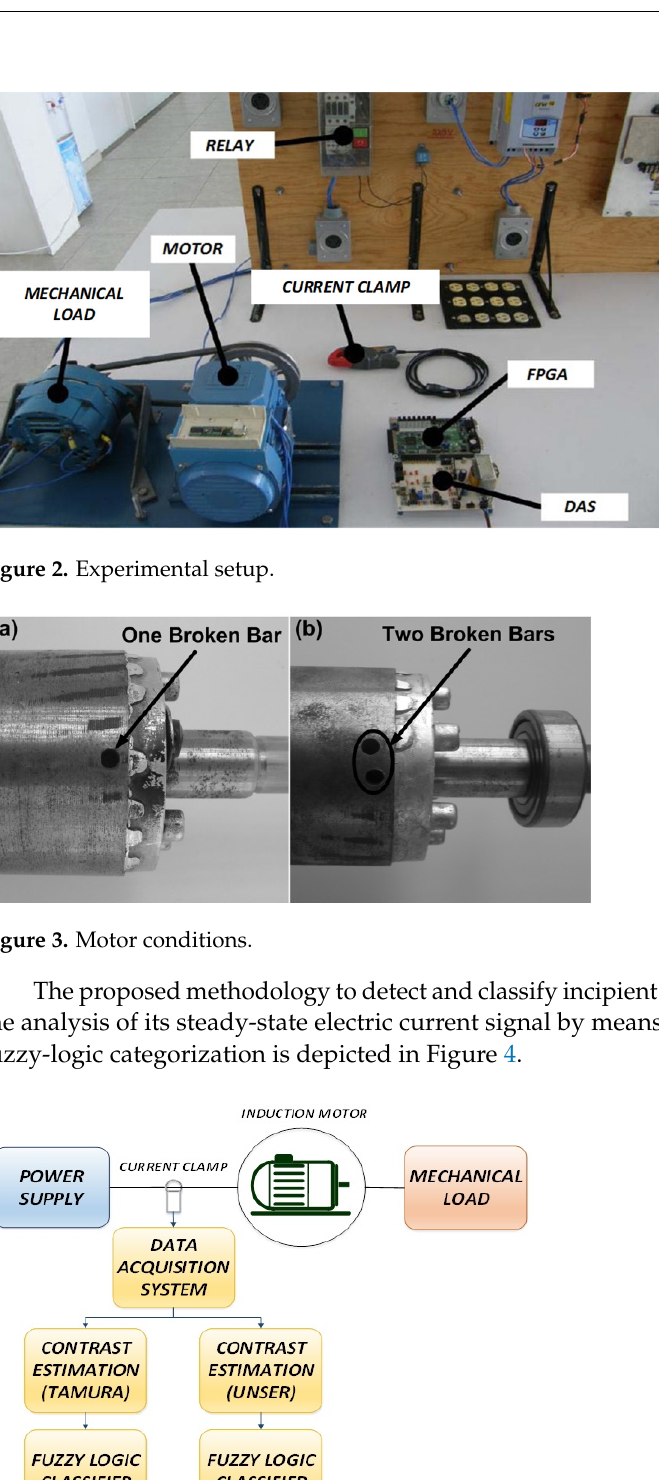
Figure 5. ( a ) Current signal acquired. ( b ) Gray-level current signal. 0